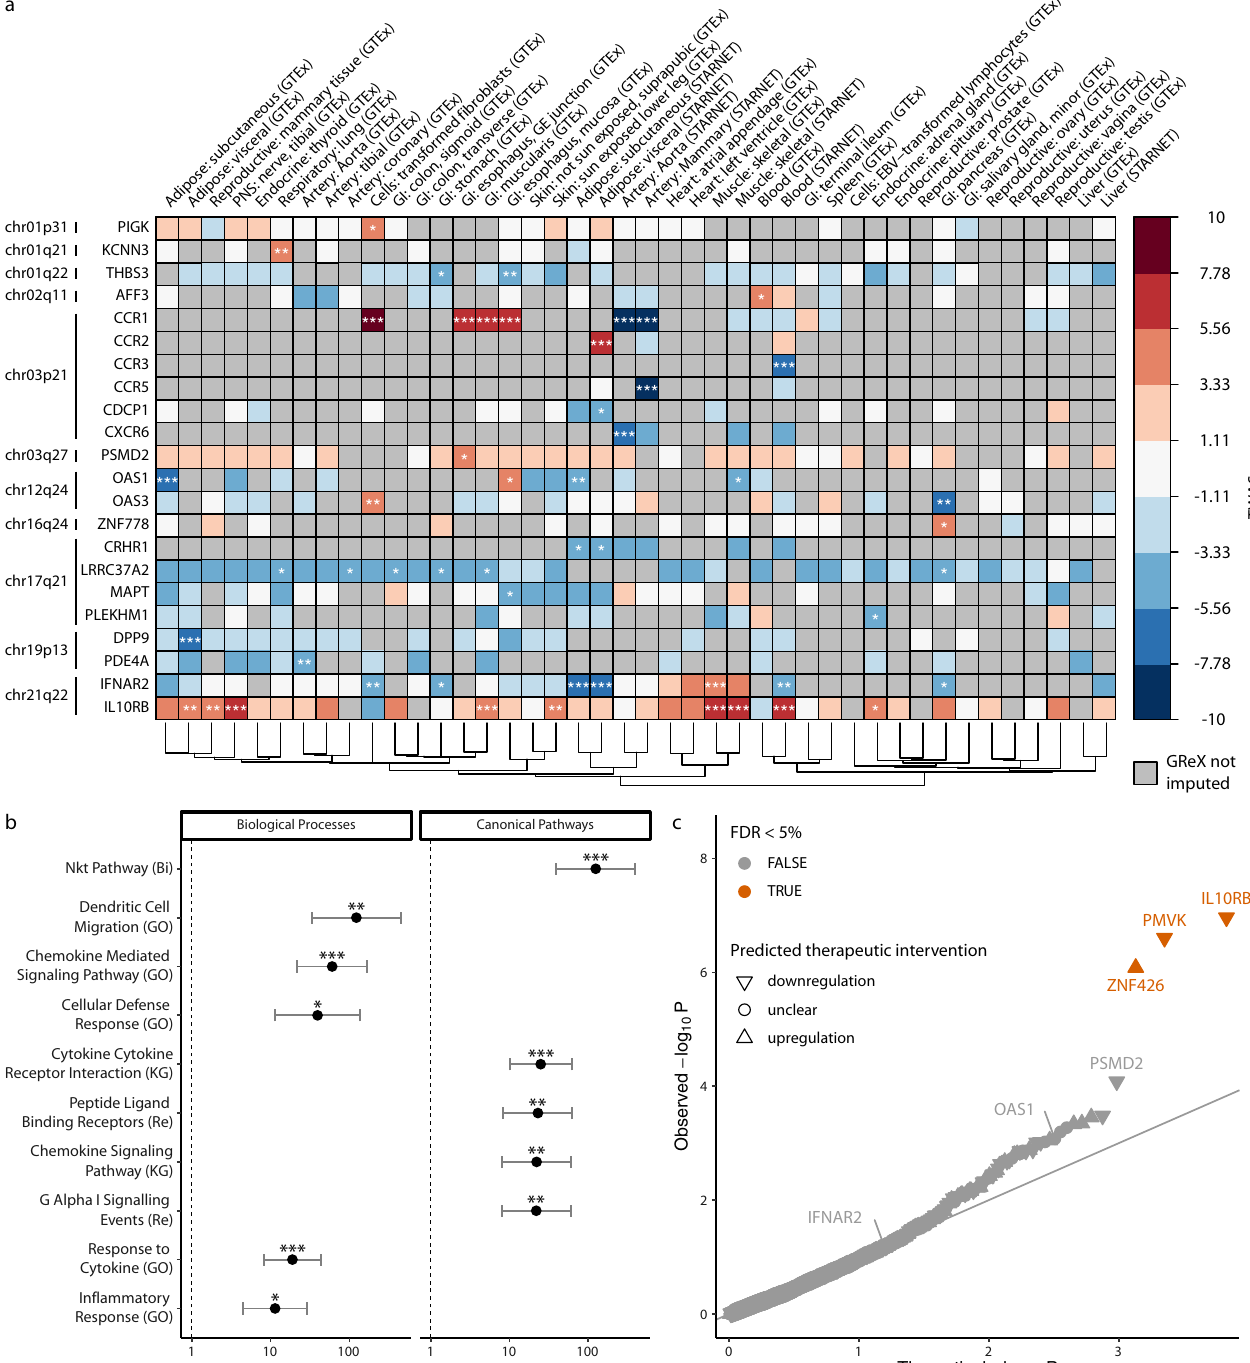
COVID-19 related death in individuals of European descent (EUR; logistic regression; OR = 1.13; Bonferroni-adjusted p = 0.01; n = 14,262) and in the trans-ethnic meta-analysis (logistic regres- sion; OR = 1.12; Bonferroni-adjusted p = 0.002; n = 23,226) (Fig. 3a and Supplementary Fig. 6); IFNAR2 GReX was not associated with COVID-19 death. However, both IL10RB and IFNAR2 GReX are associated with more severe COVID-19 clinical outcomes in EUR, participants of African descent (AFR), and in the trans-ethnic meta- analyses (ordinal logistic regression; Fig. 3a and Supplementary Fig. 6; Supplementary Table 4). It is important to note the